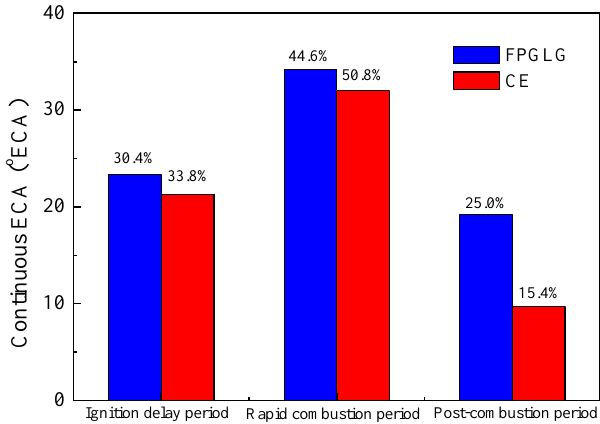
Figure 20. Different combustion stages’ comparison of the FPGLG and CE.